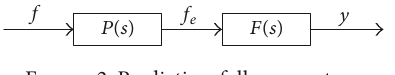
Figure 2: Prediction-follower